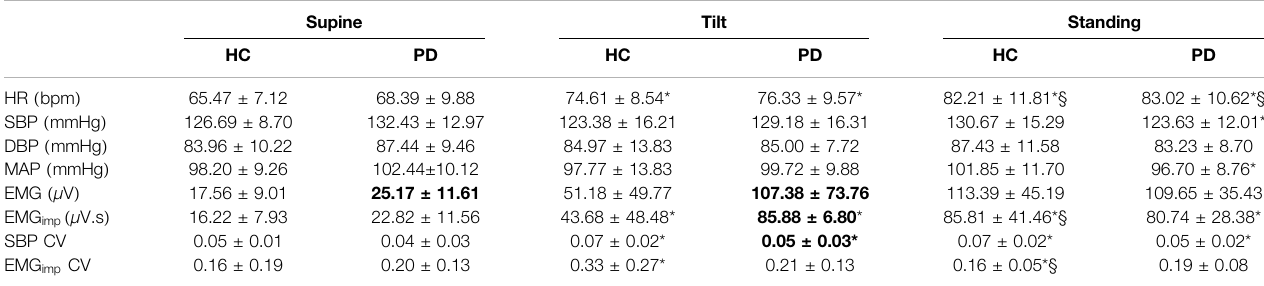
TABLE2| Cardiovascularandmusculoskeletalparameters(mean±SD)forParkinson ’ sdiseasepatientsandhealthycontrolsduringsupine,tilt,andstandingpositions.HR: heart rate; SBP: systolic blood pressure; DBP: diastolic blood pressure; MAP: mean arterial pressure; EMG: electromyogram; EMG imp beat-to-beat electromyogram; CV: coef fi cient of variation. The Bolded values indicate a signi fi cant difference (Wilcoxon rank sum test) between Parkinson ’ s patients (PD) and healthy controls (HC). *, § represent a signi fi cant difference (post-hoc analysis with Bonferroni adjustment) from supine, tilt,